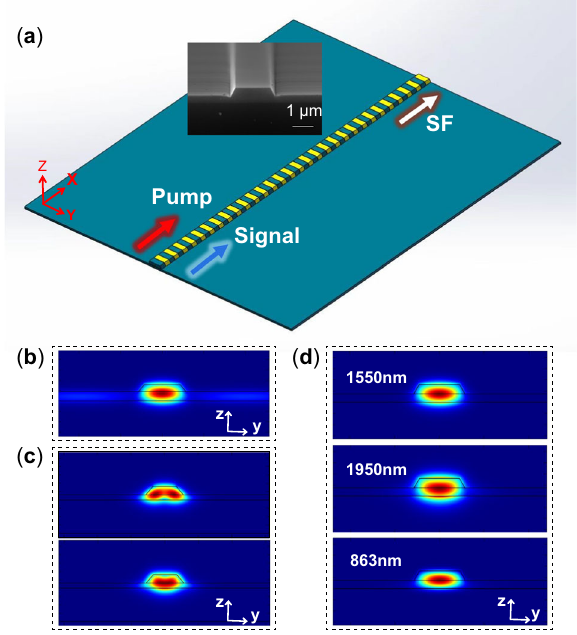
Fig. 1 QFC chip structure. a Schematic of the QFC chip. Inset is the scanning electron microscopy image of the fabricated waveguide. b Simulated pro fi les for the lateral leakage mode at 1550 nm. c Simulated pro fi les for hybrid modes at 1950 nm. d Simulated pro fi les for the quasi-TM mode of the signal, pump, and SF. The LN thickness, top width, ridge height, and sidewall angle are 800 nm, 1.8 μ m, 422 nm, and 60°,